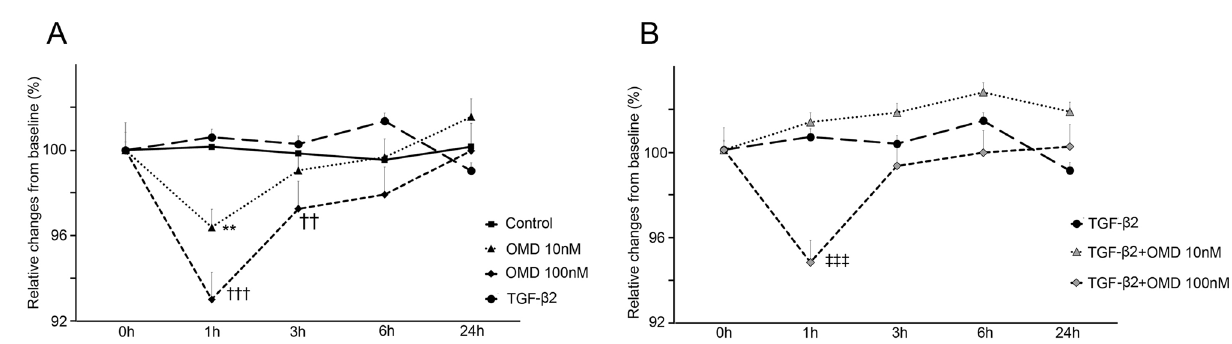
Figure 7. Effects of OMD on transendothelial electrical resistance (TEER) in SCE cells. The results of the TEER assay of the SCE cell monolayer are shown ( A , B ). At 1 h, 10 nM OMD decreased TEER significantly (** P < 0.01). OMD at 100 nM decreased TEER at 1 and 3 h compared to the control ( ††† P < 0.001 and †† P < 0.01, respectively) ( A ). OMD at 100 nM also decreased TEER at 1 h compared to TGF-β2 treatment ( ‡‡‡ P < 0.001) ( B ). Data are shown as means ± SE, n = 4 (Dunnett’s multiple comparisons